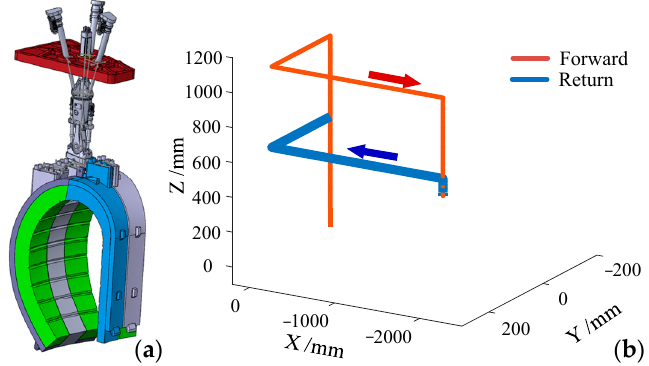
Figure 5. Left inboard BB position ( a ); lifting left inboard BB trajectory ( b ).